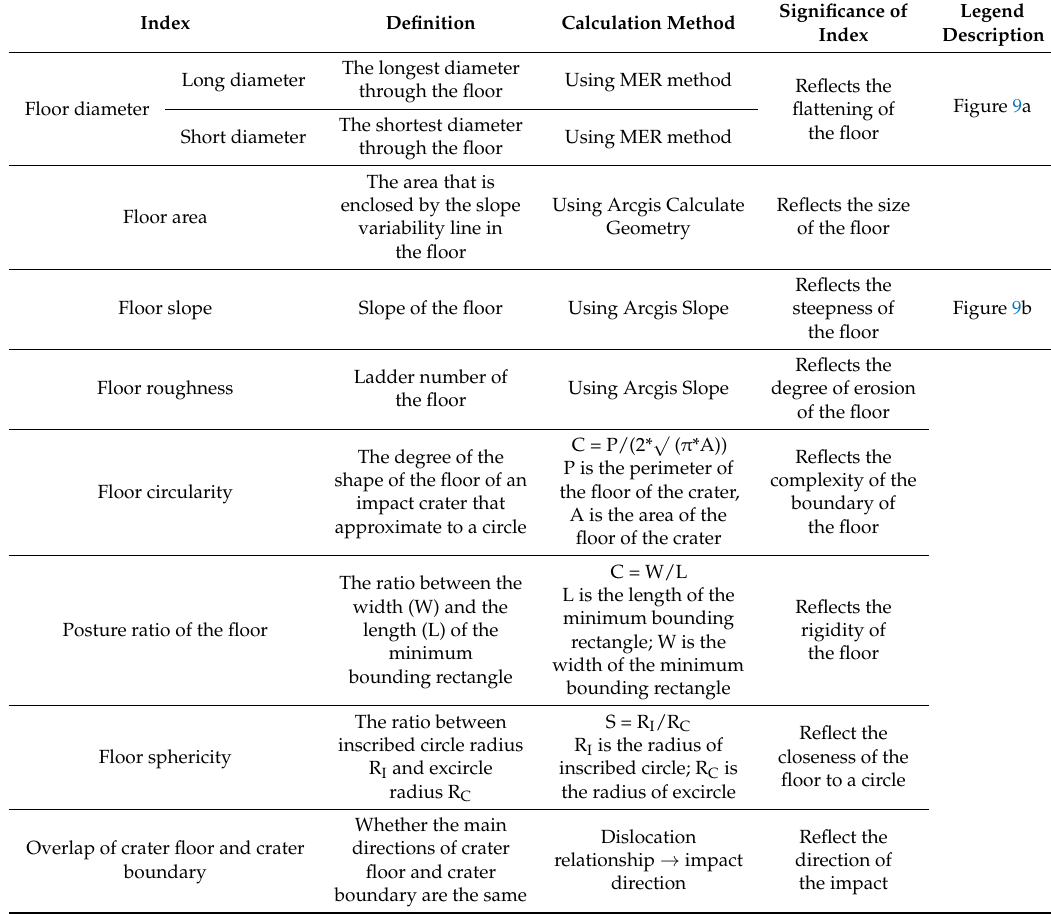
Table 4. Indices for description of the crater floor.